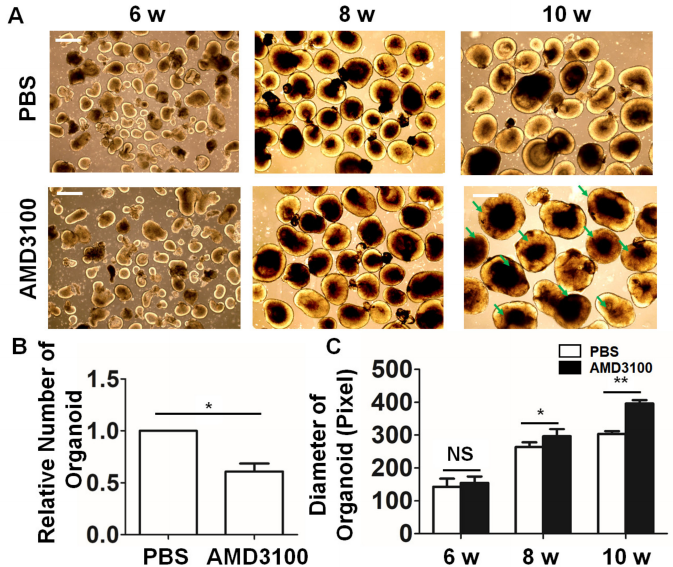
Figure 3. Blockade of CXCR4 with the antagonist AMD3100 affects the formation of retinal organoids. ( A ) Images of retinal organoids in the PBS and AMD3100 treatment groups during differentiation. Most retinal organoids treated with AMD3100 showed nontransparent NRs at 10 weeks (green arrowhead). ( B ) The relative numbers of organoids were evaluated in the PBS and AMD3100 treatment groups, and the generation ratio of the organoids significantly decreased (* p < 0.05, three independently repeated inductions of retinal organoids were counted). ( C ) The assay of organoid diameters showed that AMD3100 treatment resulted in larger diameters (* p < 0.05, ** p < 0.01, NS: Not Significant, p > 0.05, n = 120). Scale bars: 100 µ